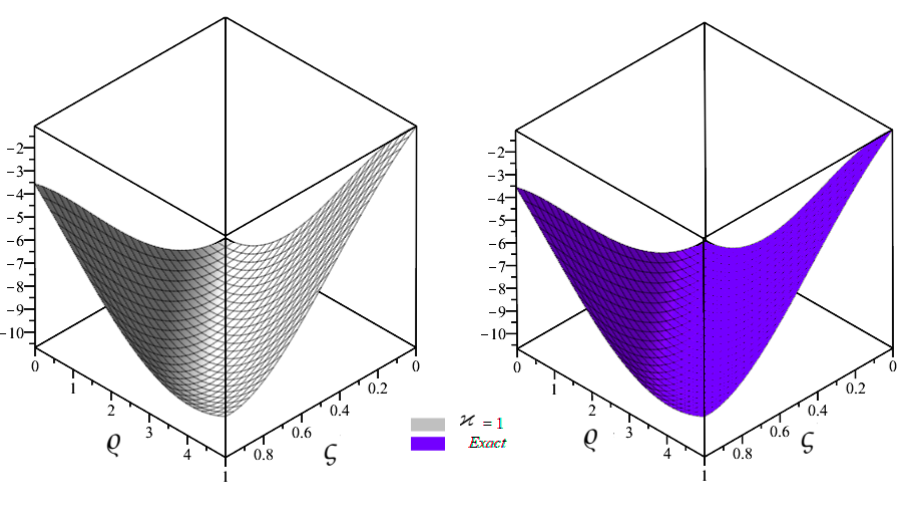
Figure 3, the analytical solutions of different fractional order κ of Problem 2. Figure 4, the analytical solutions of different fractional order κ of Problem 2. Table 2, absolute error of exact and q-HATM of Problem 2 of different fractional order of ς and (cid:36) for κ = 1 .